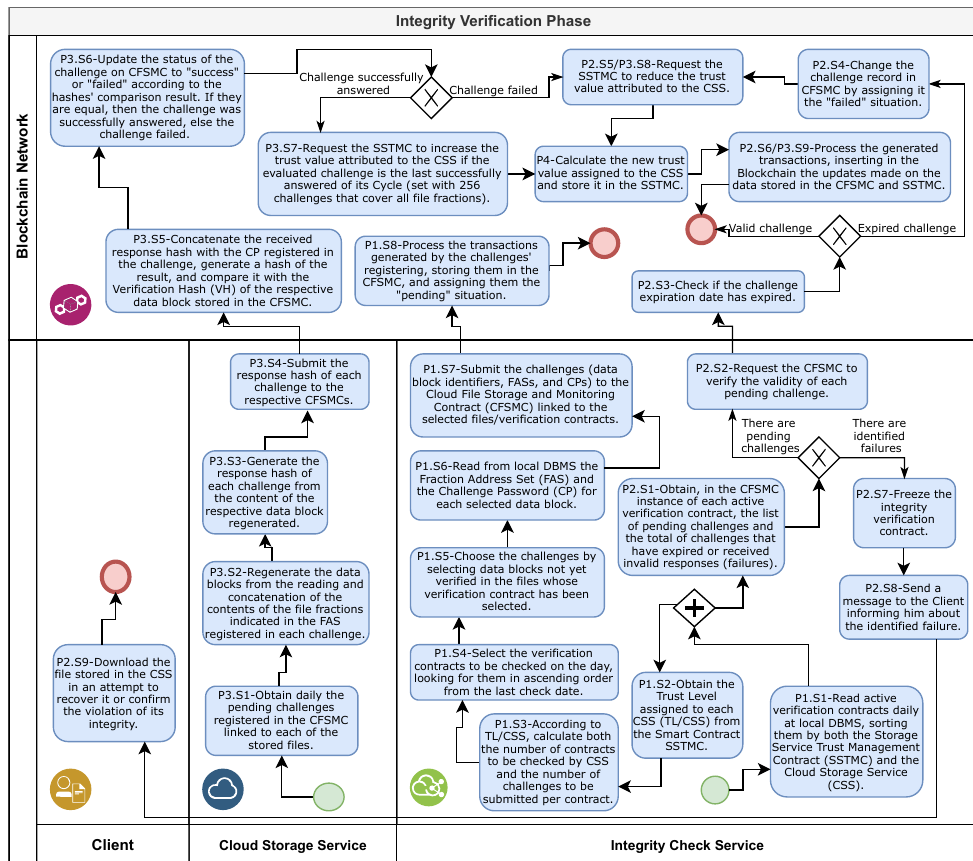
Figure 7. Integrity verification phase